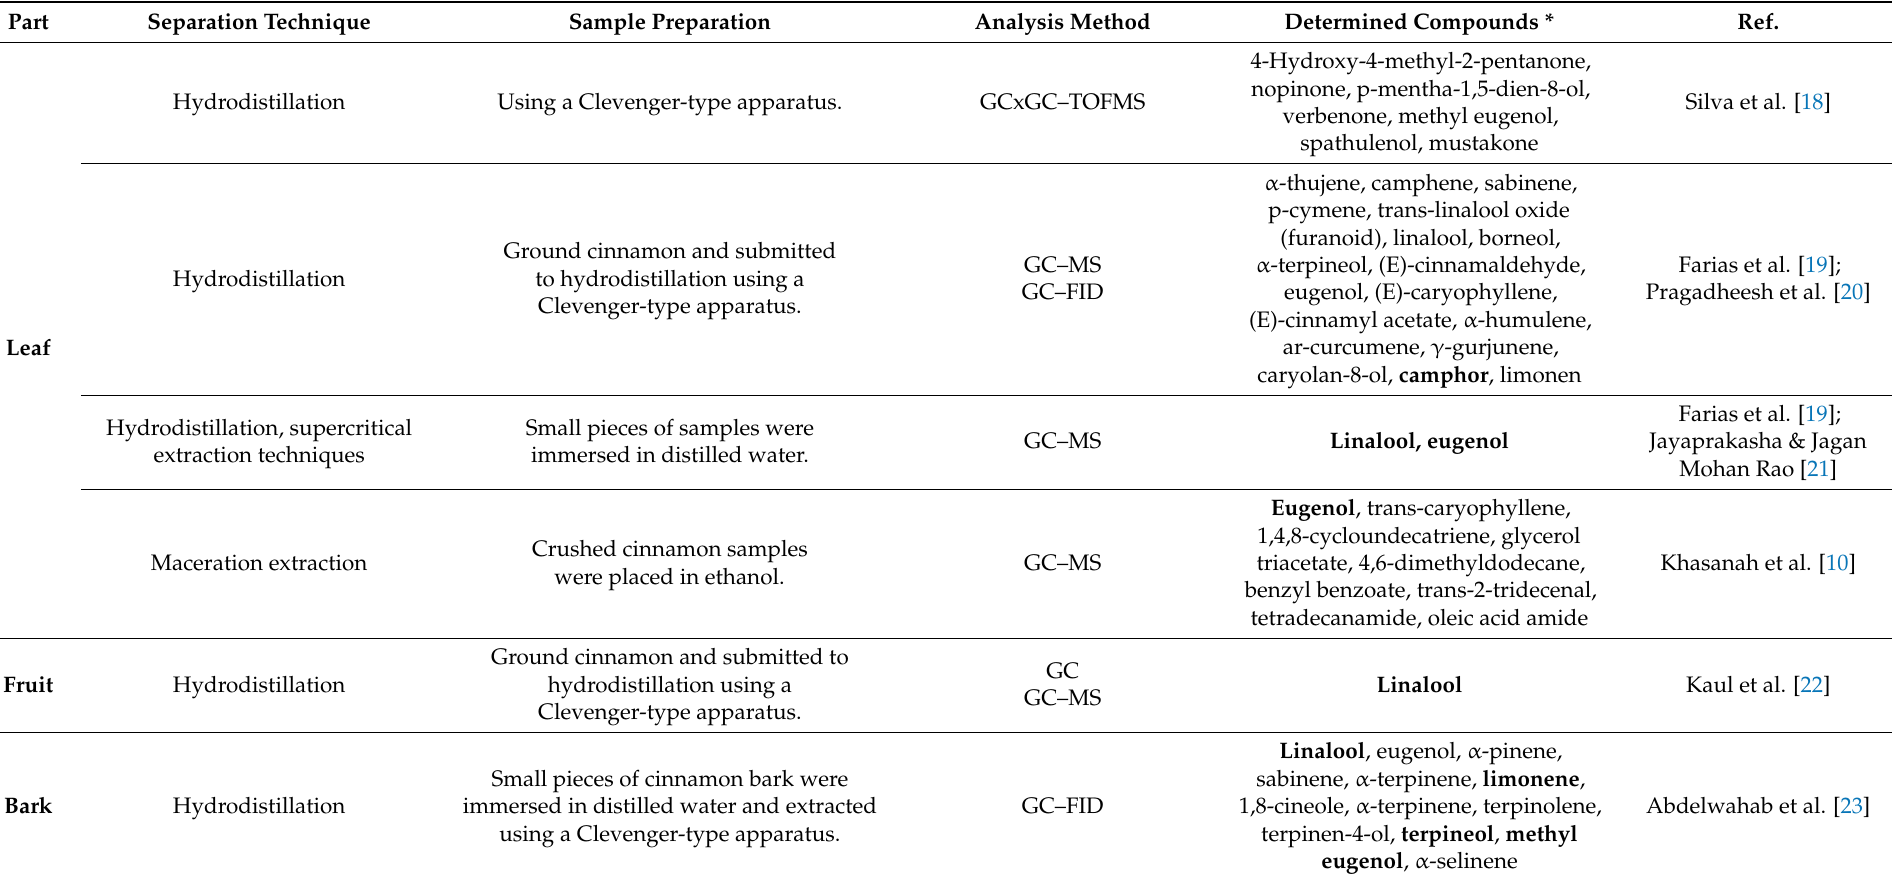
Table 1. Selected separation methods and analysis techniques of the determination of compounds in cinnamon